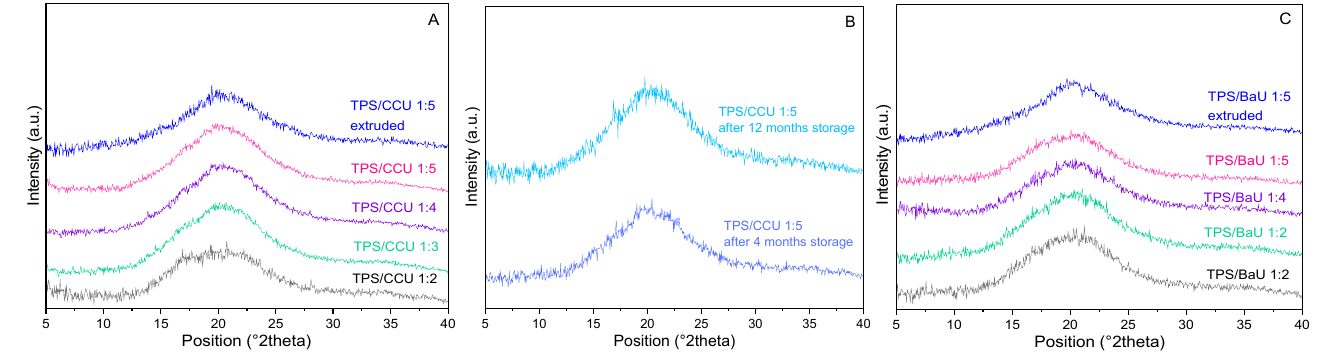
Figure 3 . XRD patterns for the films plasticized with DESs: ( A ) based on CC with different U content; ( B ) TPS/CCU 1:5 after storage at ambient conditions; ( C ) based on Ba with different U content .